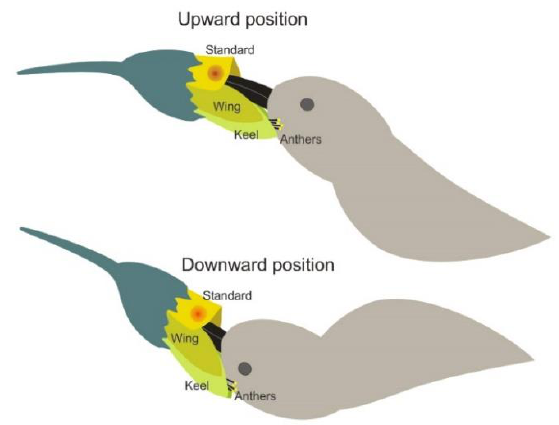
F IGURE 5. Diagram of downward and upward legitimate approaches of pollinating birds to A. foetida